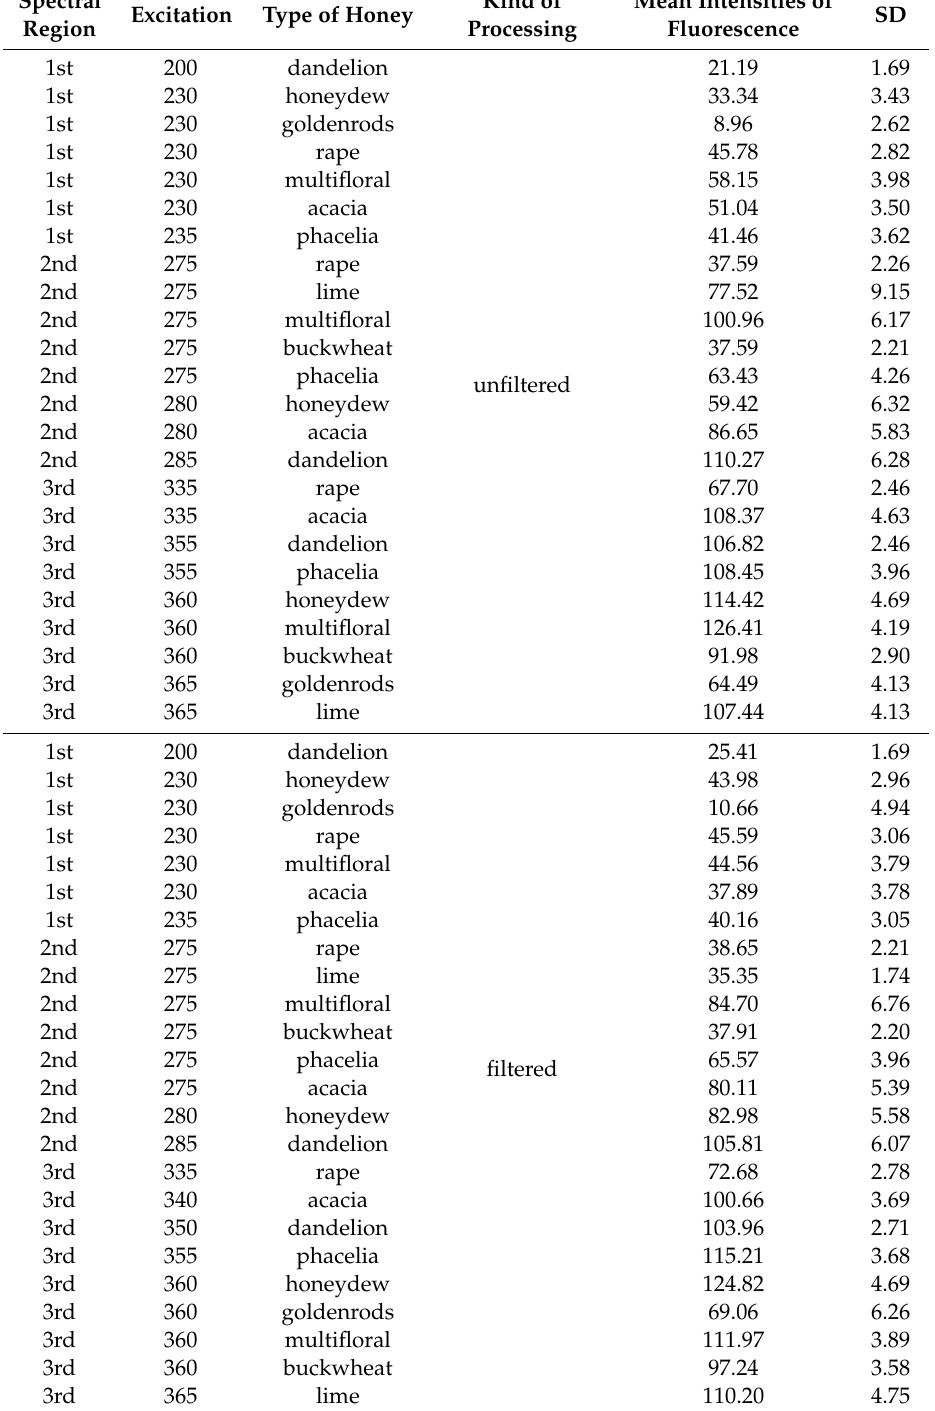
Table 1. Mean emission intensities over characteristic spectral regions for filtered and unfiltered honeys of di ff erent